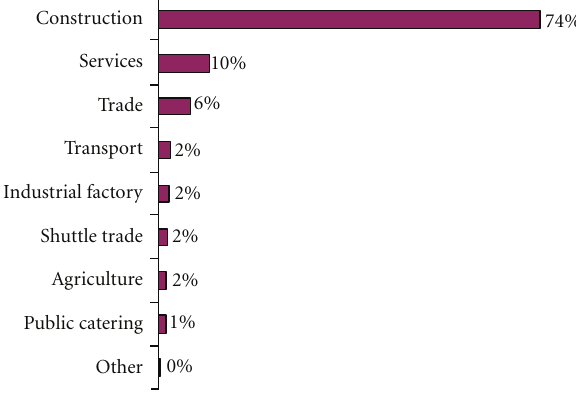
Figure 1: Type of employment abroad.